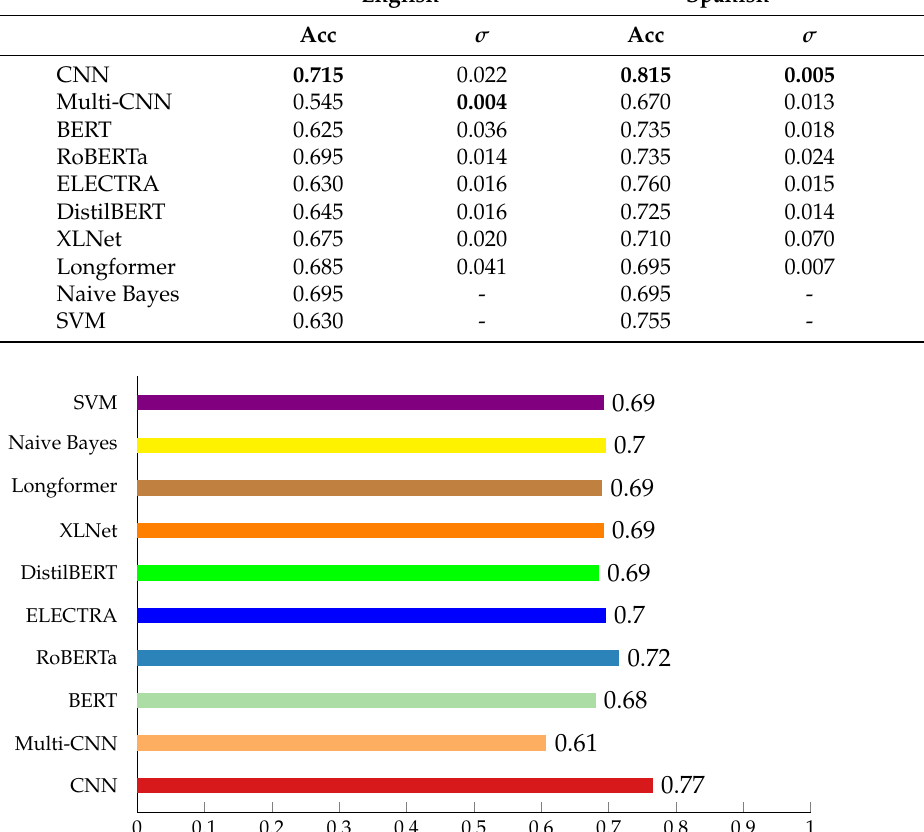
Figure 4. Average accuracy of each model evaluated. AVG accuracy is calculated averaging the accuracy in each language (Spanish and